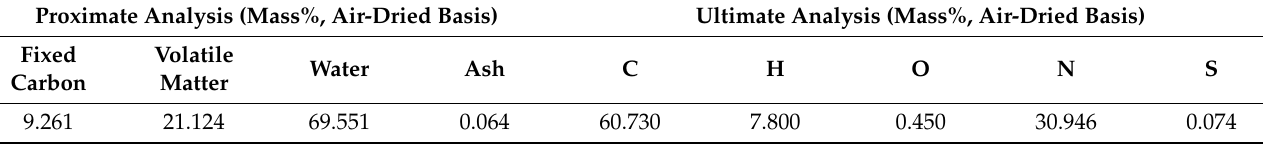
Table 2. Properties of the biomass